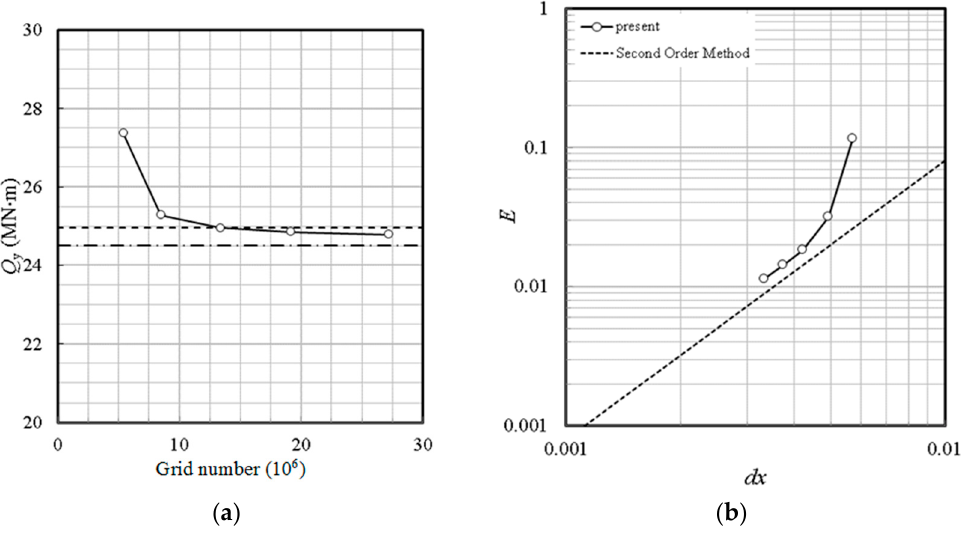
Figure 13. ( a ) Dependence of aerodynamic load on grid number; ( b ) discretization error.